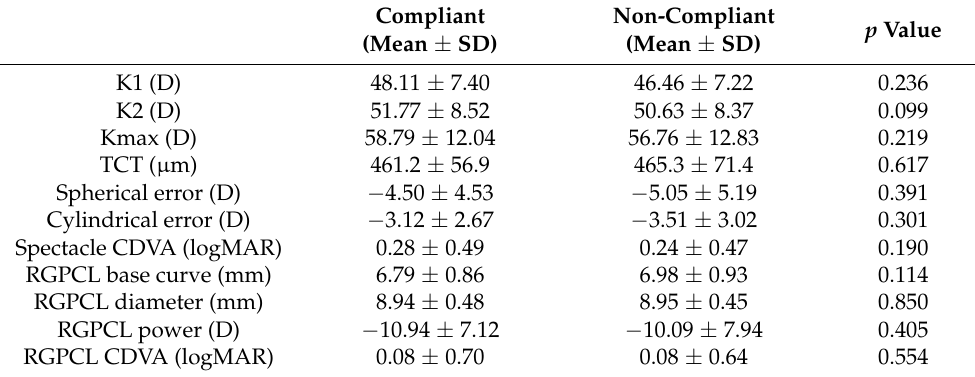
Table 2. Clinical data of the respondents (308 eyes, compliant; 66 eyes, non-compliant).